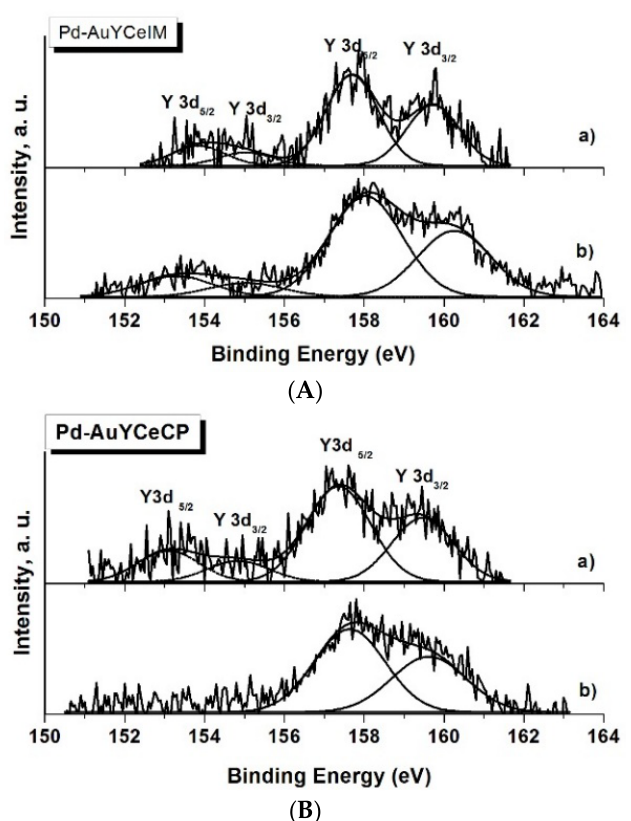
Figure 7. Y 3d XP spectra of: ( A ) Pd–AuYCeIM catalyst as: (a) fresh and (b) after CBO; ( B ) Pd–AuYCeCP catalyst as: (a) fresh and (b) after CBO.